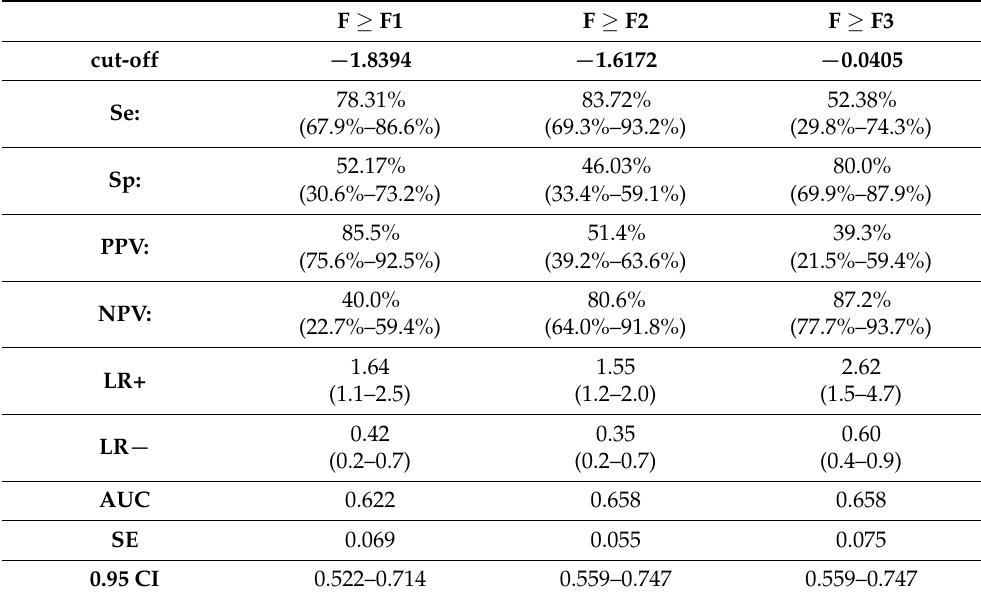
Table 9. The diagnostic performance of NFS for fibrosis grades greater than or equal to 1, greater than or equal to 2, and greater than or equal to 3.